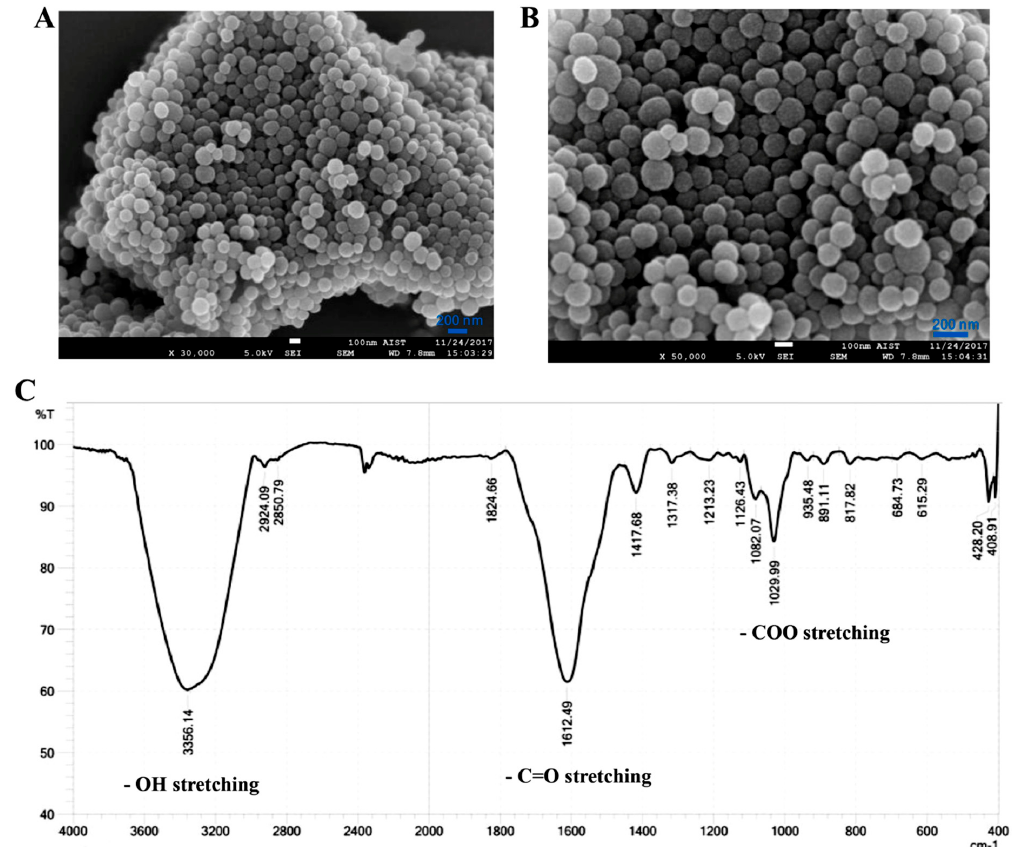
Figure 1. Melanin powder under a SEM at different magnifications of 30,000 × ( A ) and 50,000 × ( B ); and chemical functional groups detected on melanin, measured by FTIR ( C ).